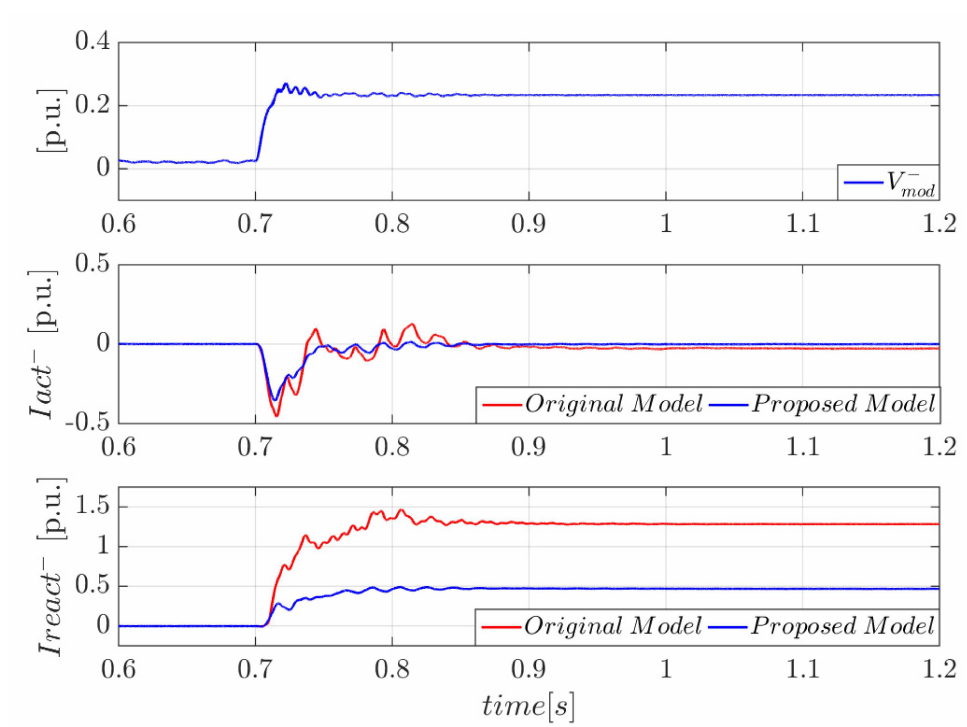
Figure 28. Negative sequence voltage and currents during the unbalanced fault for both